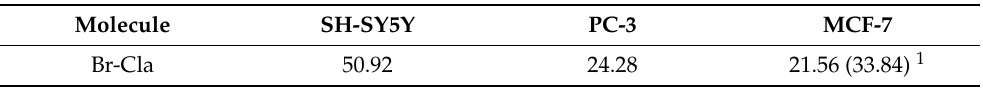
Table 1. IC 50 (in µ M) values for Br-Cla in neuroblastoma SH-SY5Y, prostate PC-3, and breast MCF-7 cancer cell lines. Assays were performed with either 48 (SH-SY5Y) or 72 h (PC-3 and MCF-7)